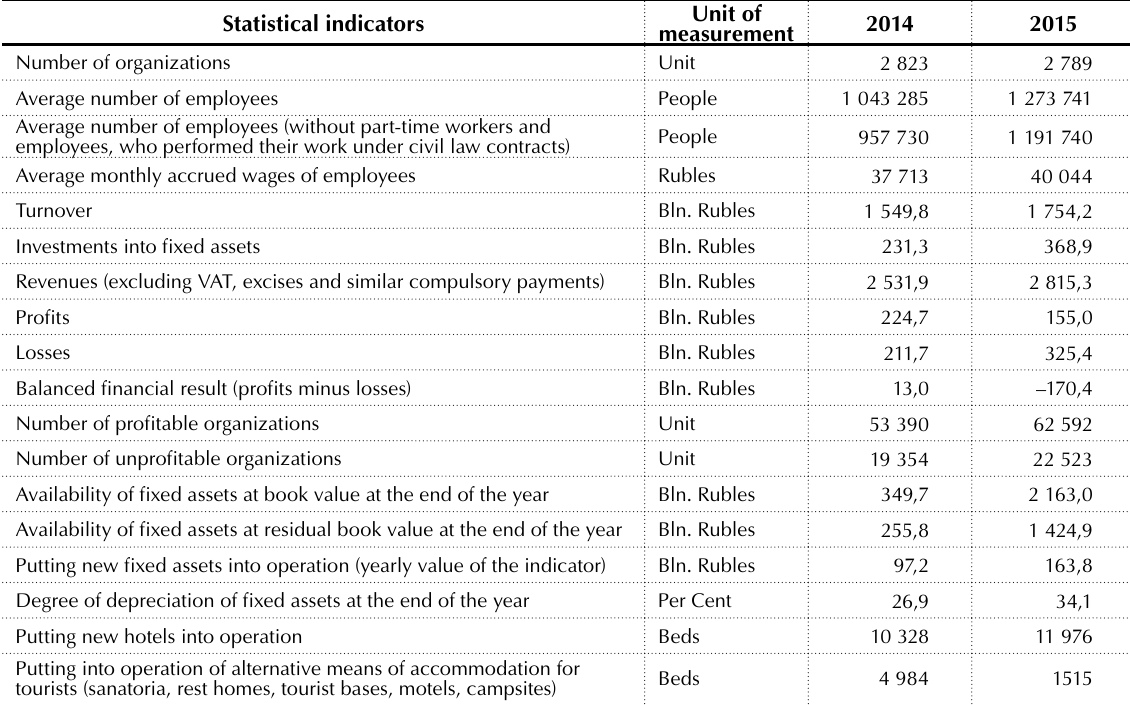
Table 1. Indicators of activities of tourist organizations in Russia, according to the data (Ofitsialnaya statistika